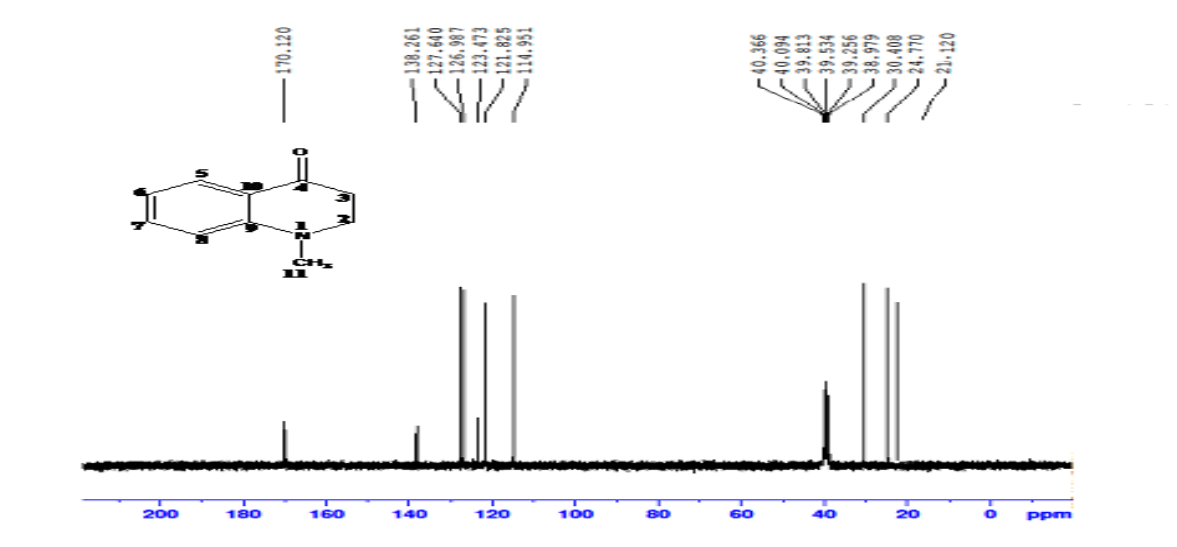
Figure 6 : 13 C-NMR analysis of the isolated E2